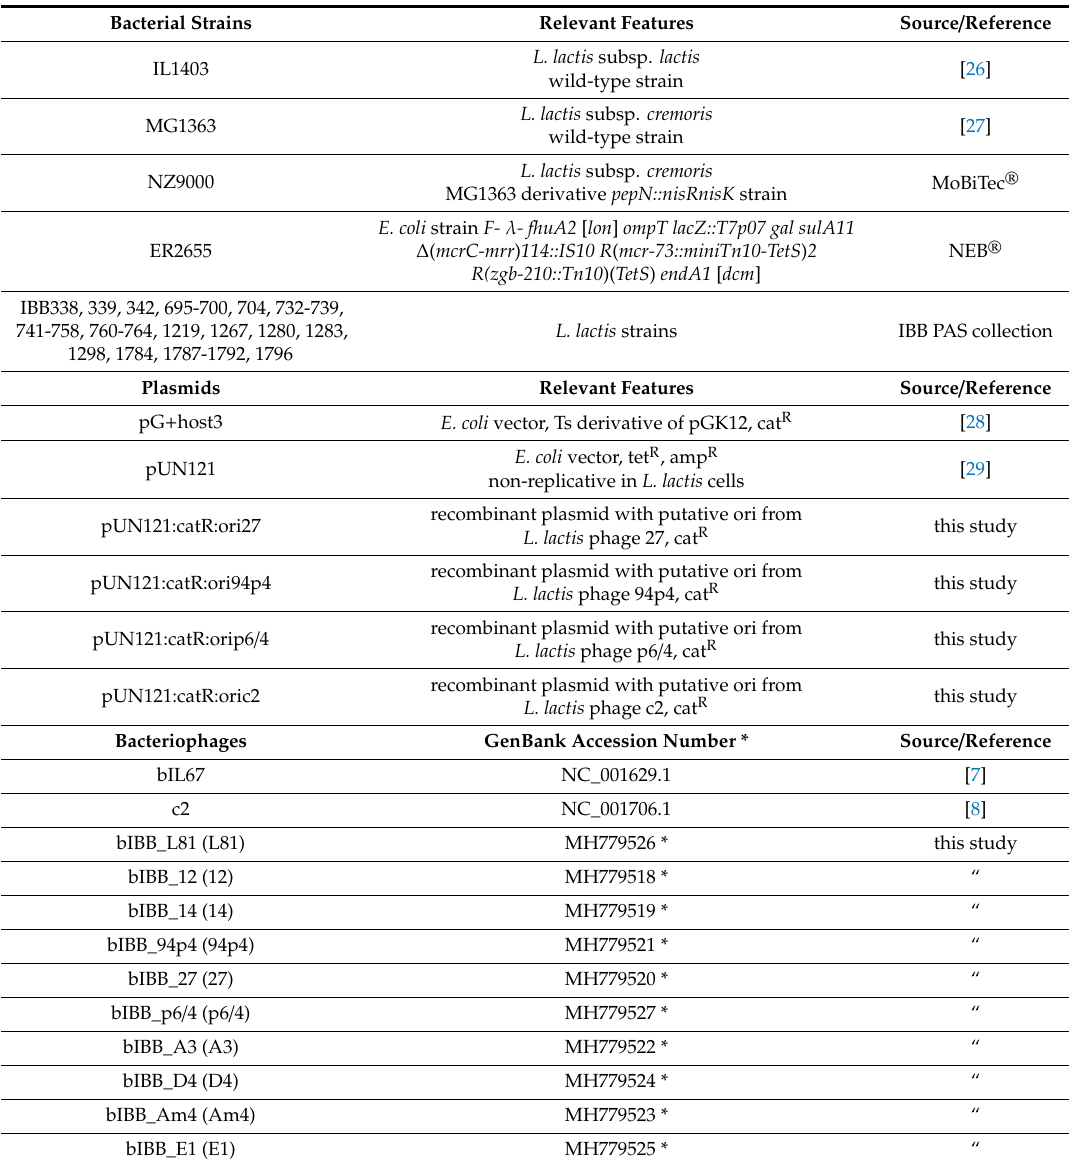
Table 1. Bacterial strains, plasmids, and bacteriophages used in